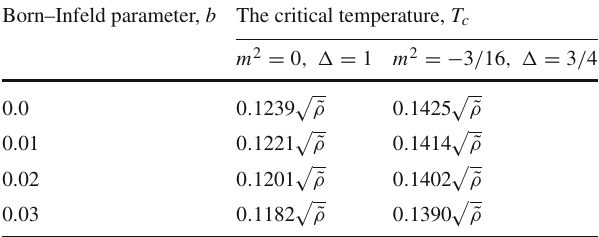
Table 1 Critical temperature with the Born–Infeld correction Born–Infeld parameter, b The critical temperature, T